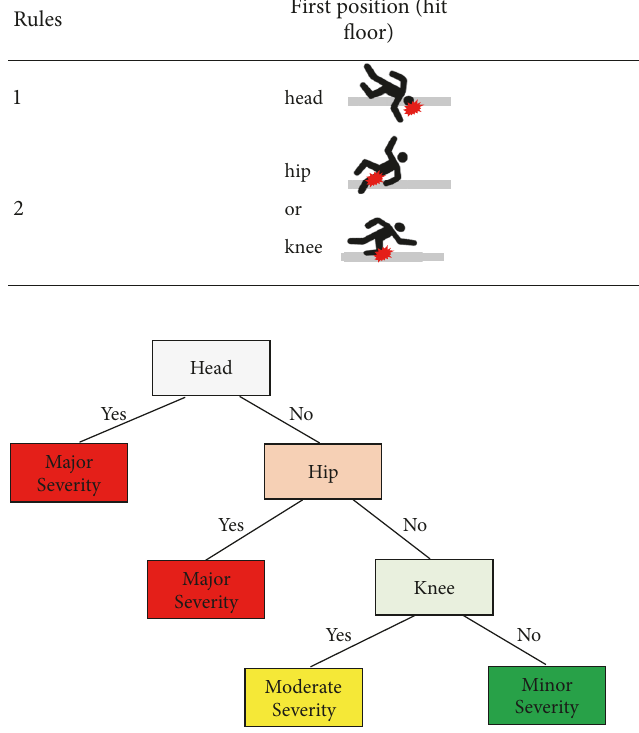
Figure 3: Body-joint fall impact divided into severity